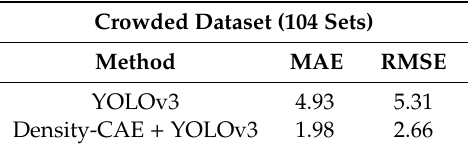
Table 2. Performances of di ff erent methods for the crowded bus